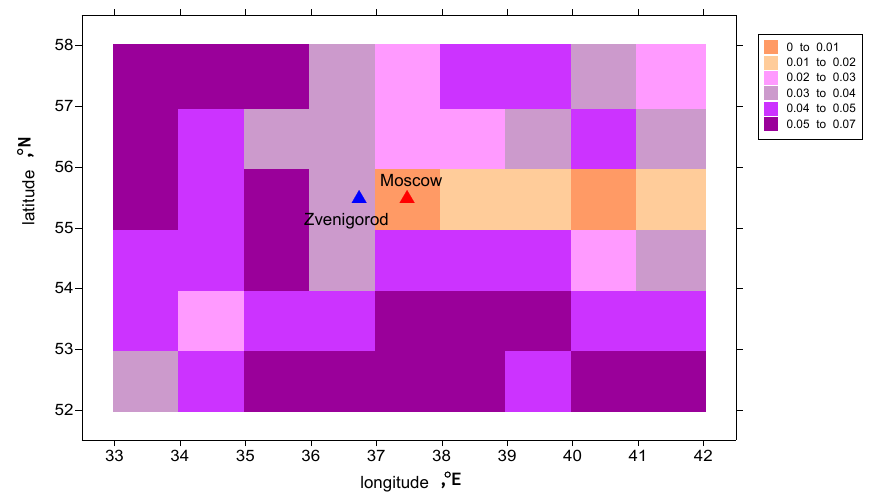
Fig.6. Average difference in AOT550 over Moscow region and nearby territory. MODIS data, collection 5.